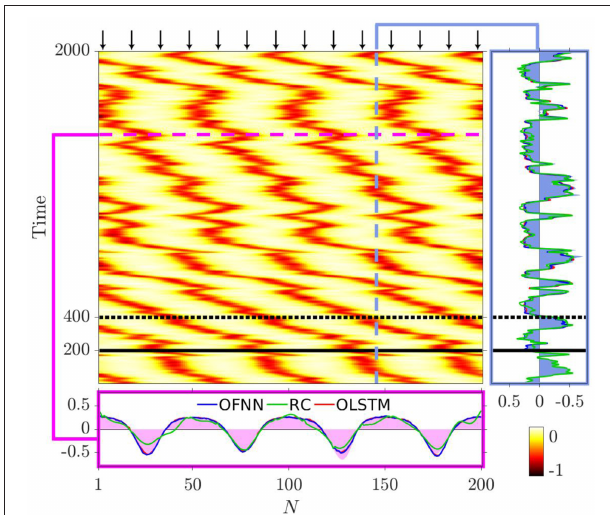
FIGURE 2 | Spatiotemporal plot of a turbulent chimera state [as is generated in the 1-dimensional semiconductor Class B laser array of Shena et al. [ 23] Figure 4V], depicting the evolution of the local curvature for each laser (values are color-coded), studied numerically for a non-local coupling scheme. Seventeen “observers” have been placed in the positions marked by the tips of the arrows. The thick horizontal black line represents the size of the training dataset used for training the reservoir observers with RC, while the dotted horizontal black line represents the size of the training dataset for training the OLSTM (and OFNN) observers. Right, vertical inset: the predicted time series for laser #145: shaded blue color depicts the actual (ground-truth) data, red line depicts prediction by OLSTM, green line depicts prediction by RC, blue line depicts prediction by OFNN. Bottom inset: snapshot of the spatial profile of the predicted local curvatures for the entire array at time step t n = 1,500: color code is as in the right inset, but with pink color depicting the actual (ground-truth)